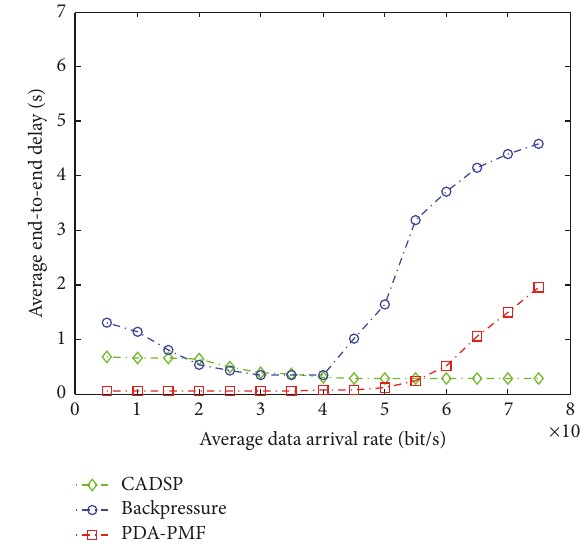
Figure 3: Comparison of average end-to-end delay of service 1 in multihop network.